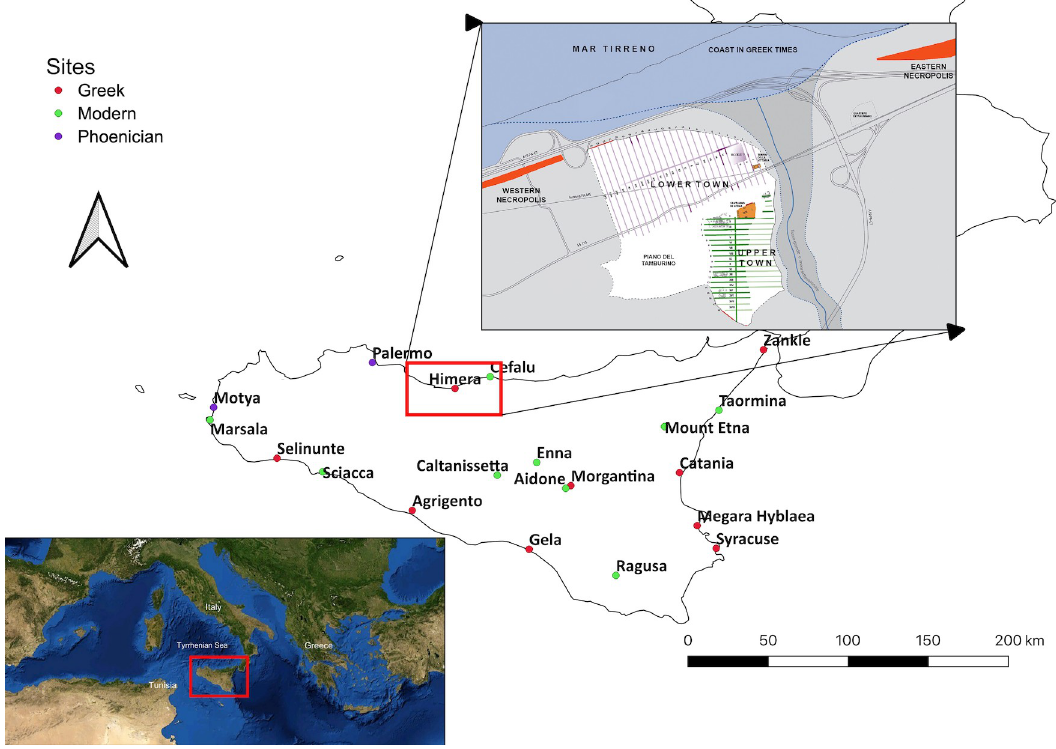
Fig 1. Map of Sicily showing Greek and Phoenician colonies in the 5 th century in the context of modern towns. The plan of Himera shows the relation of the Upper and Lower towns to the river and the Western necropolis where the Battles of Himera were fought along the western fortifications. Public domain image of the Mediterranean Sea via Wikimedia Commons from NASA World Wind, modified to show location of Sicily. Map of sites in Sicily created in QGIS by KLR and plan of Himera created by SV.